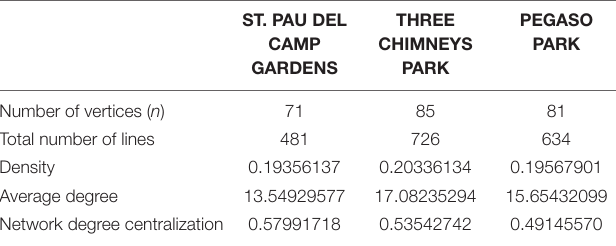
TABLE 2 | Descriptive parameters of the networks obtained in each case